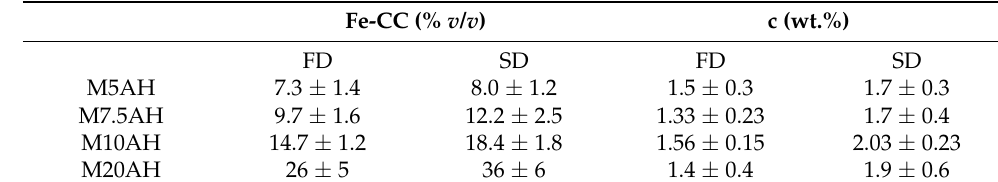
Table 2. Magnetic particle concentration (Fe-CC) and alginate concentration (c) of the different hydrogels after the first and second dehydration (FD and SD, respectively).